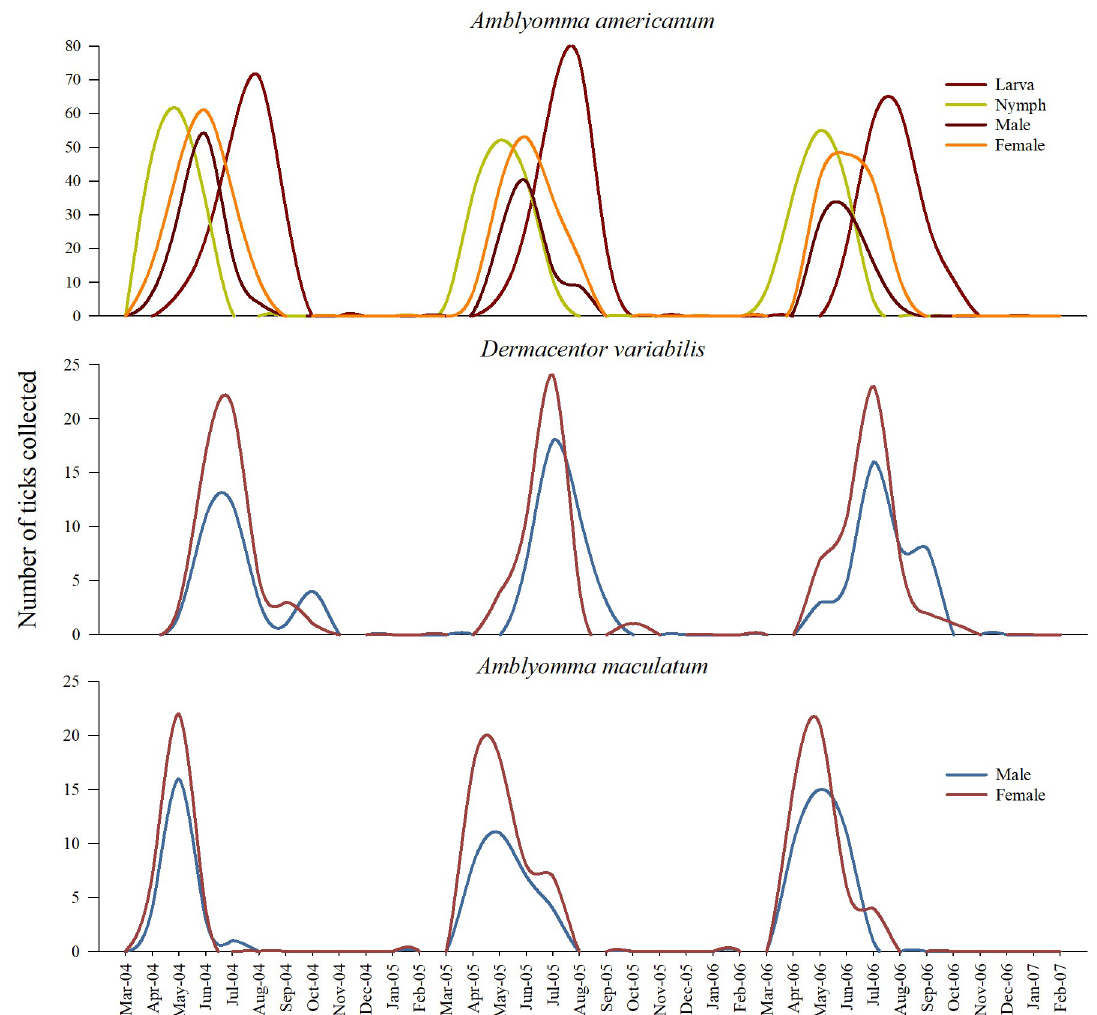
Fig 5. Tick phenology observed in predominantly grassland vegetation near Pittsburg, Kansas between years 2014–2017. Lines represent total number of individual specimens collected at monthly intervals and are not smoothed